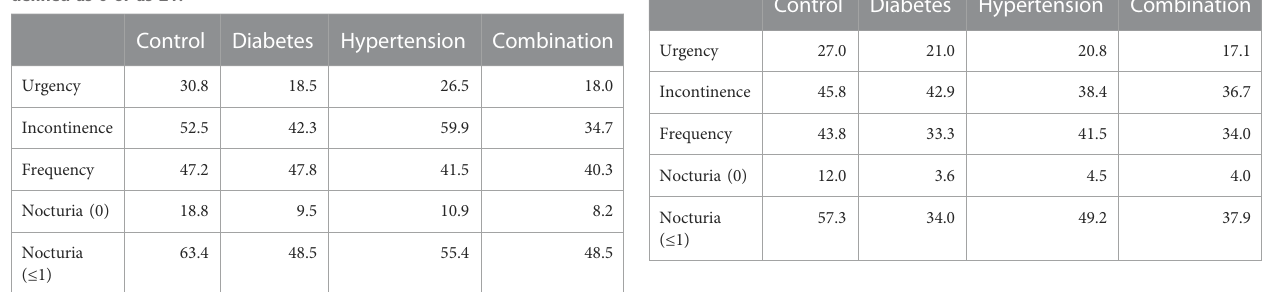
TABLE 3Patients becoming free of a given symptom upon treatmentin study I Data are shown as % of patients who had exhibited a symptom at baseline but didnotatendofstudy.Notexhibitingasymptomwasde fi nedas0forurgency and incontinence and as ≤ 7 for micturition frequency. For nocturia it was de fi ned as 0 or as ≤ 1.